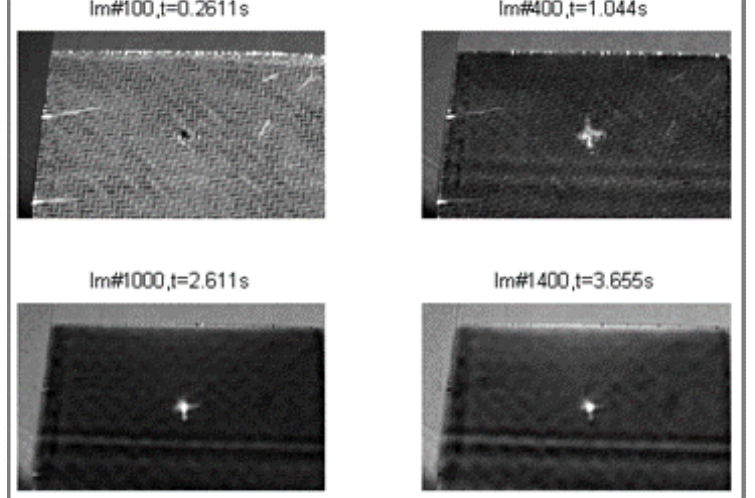
Figure 9. Catastrophic damage of the specimen shown by the thermography analysis after impact testing at 5 J, the second derivative of